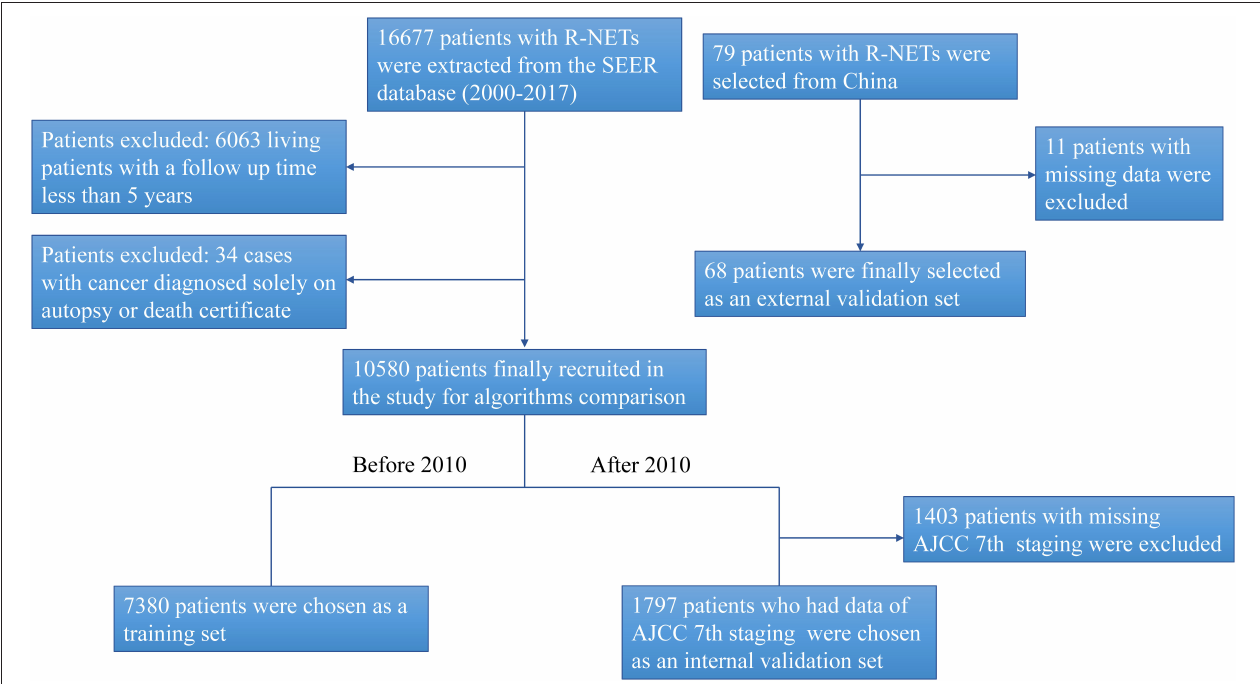
FIGURE 1 | The flow chart for study identification, screening, and inclusion in the training set and validation set.